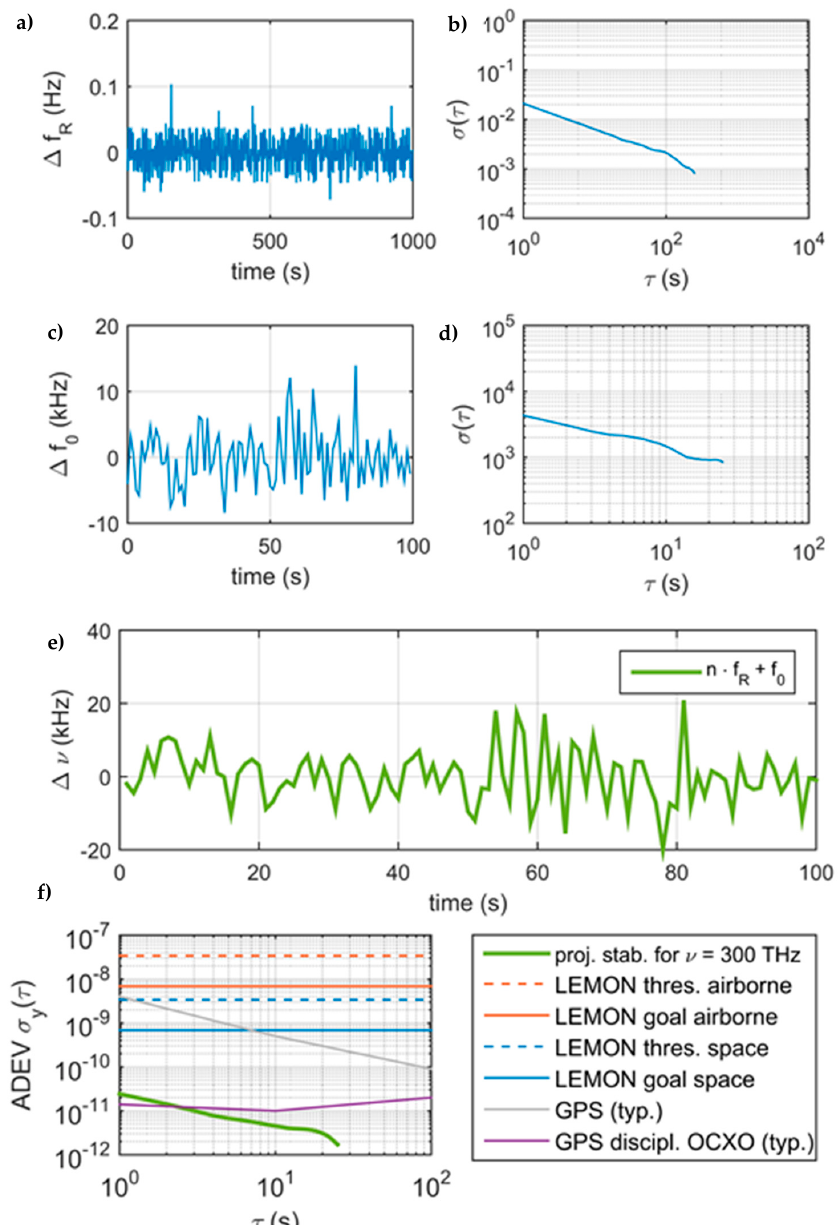
Figure 22. Frequency measurement ( a ) and stability of the stabilized repetition rate ( b ), frequency measurement of the offset frequency ( c ), and its stability ( d ). Combined frequency behavior of an optical comb mode at a wavelength of 1 µm ( e ) and achieved stability in comparison with performance requirements ( f ).